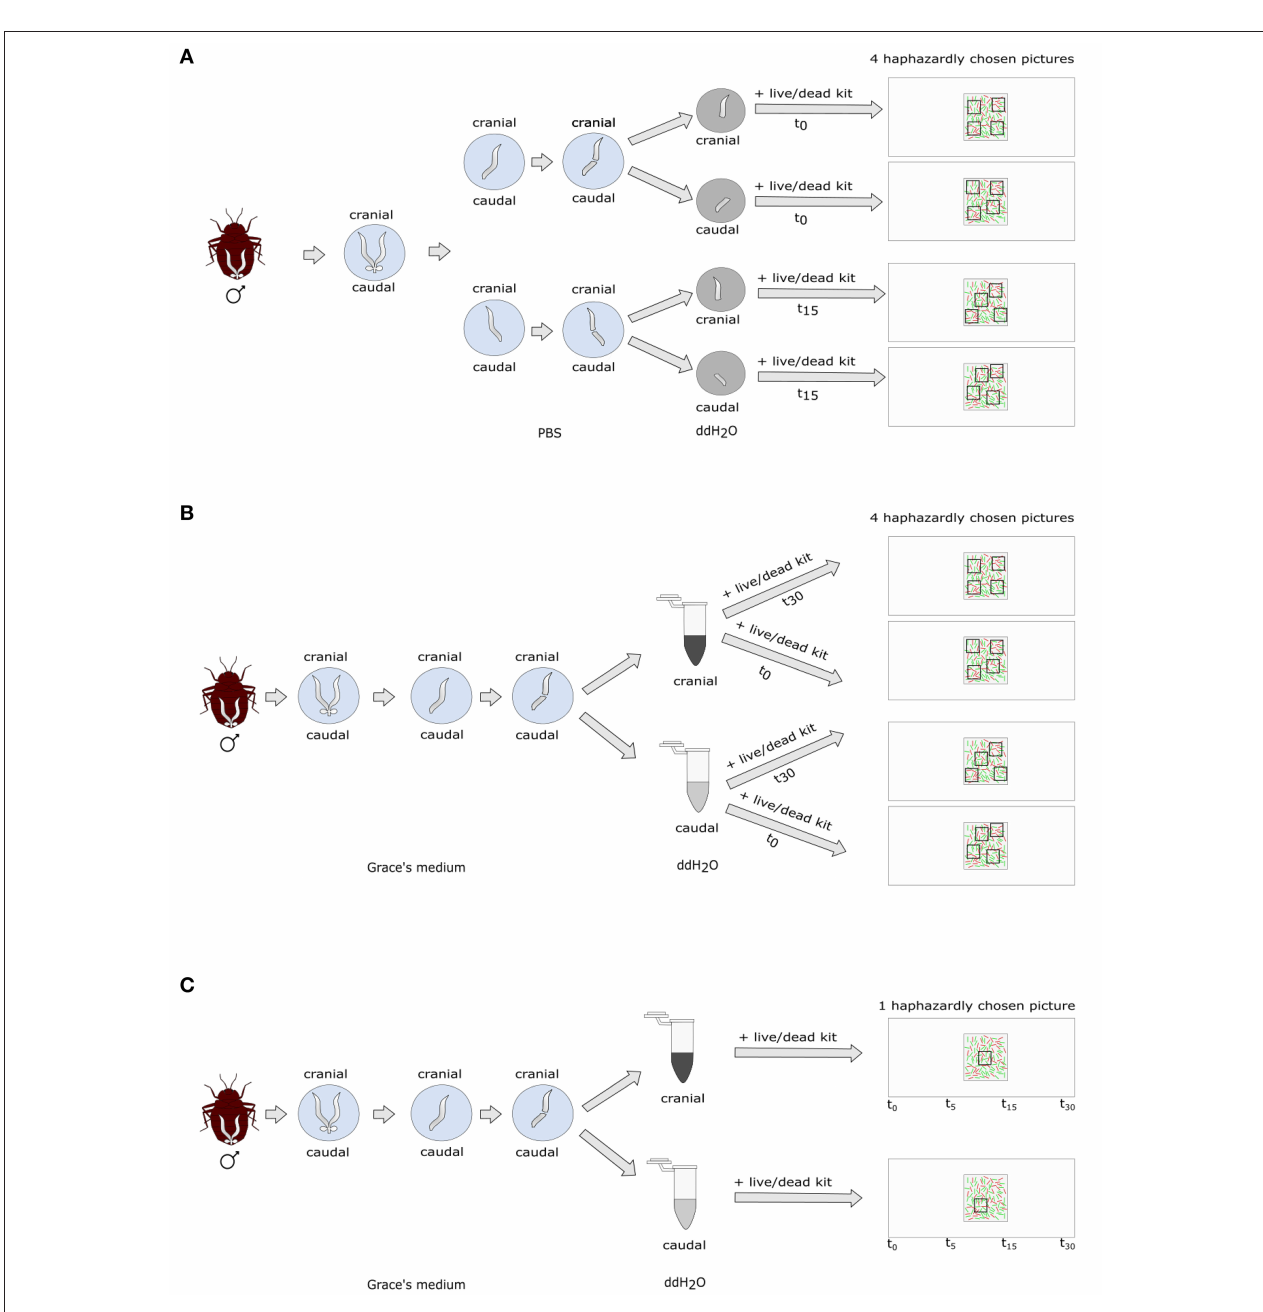
FIGURE 1 | Experimental protocol of (A) non-blind standard sperm count; (B) blind standard sperm count; (C) blind time series count.